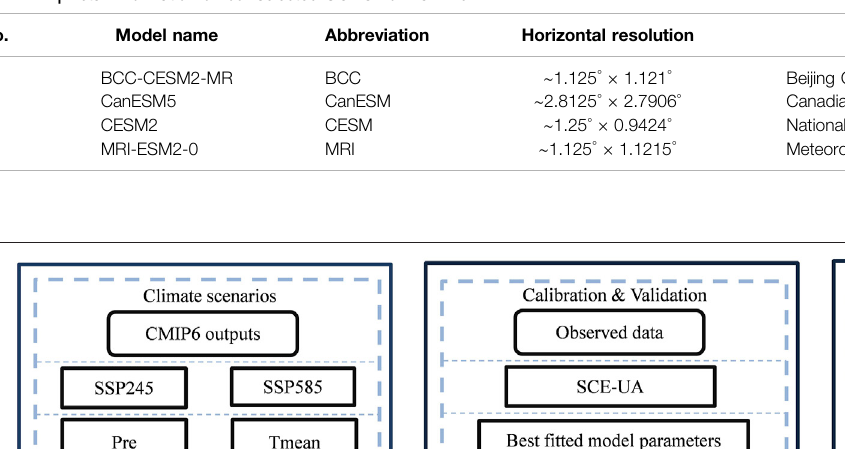
TABLE 1 | Detail information of four selected GCMs from CMIP6.